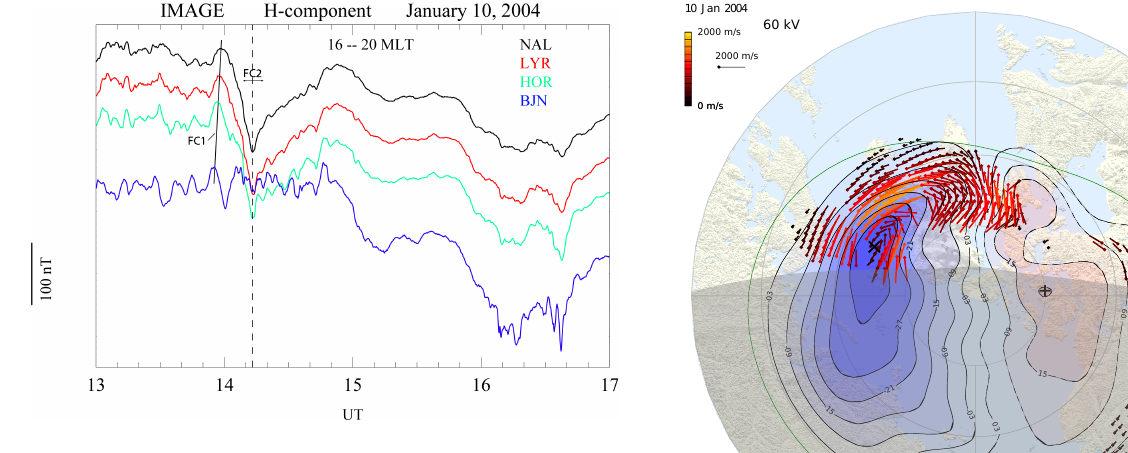
Fig. 3. H-component magnetograms from the IMAGE Svalbard chain of stations during the interval 13:00–17:00UT. Panels from top to bottom shows magnetograms from stations NAL (76 ◦ MLAT; black trace), LYR (75 ◦ MLAT; red), HOR (74 ◦ MLAT; green), and BJN (71 ◦ ; blue). The vertical guideline at 14:12UT marks the time of observation by SuperDARN radars of flow channel FC 2 (NH- dusk/ B y < 0) above Svalbard, representing the maximum phase (14:08–14:15UT) of the magnetic deflection/convection event. The FC 2 event is marked in the figure. The positive H-deflections propagating poleward from BJA to NAL during the interval 13:50– 14:00UT are also marked. This feature corresponds to the activa- tion of flow channel FC 1 (see Fig. 1).